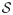
Schematic of the model structure.A: The different infection states in the model (susceptible S, pre-symptomatically infected E, symptomatically infected I, treated R) and their relative infectiousness hi(t − Ei) over time t for a VL case i with infection time Ei, incubation period IPi, symptom onset time Ii and treatment time Ri. B: The infectious pressure λi(t) on susceptible individual i at time t is the sum of the transmission rates from the infectious individuals around them (here ji, j2 and j3), which are a function (represented by the bell-shaped curves) of the distances of the infectious individuals from i (the arrow shows the distance di1 between i and j1) and the times since their infections.